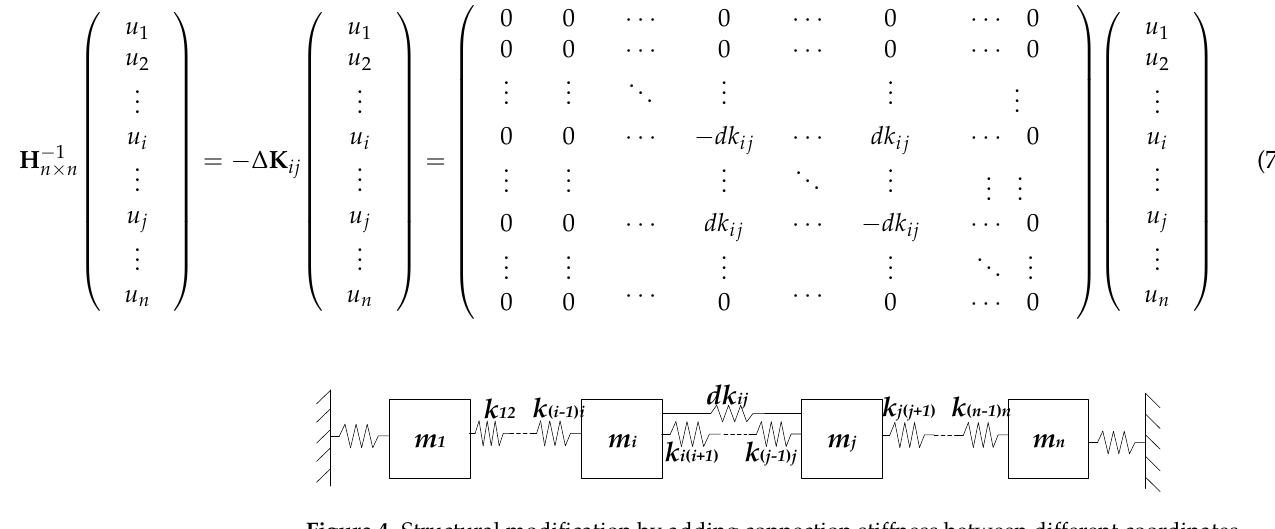
Figure 4. Structural modification by adding connection stiffness between different coordinates.